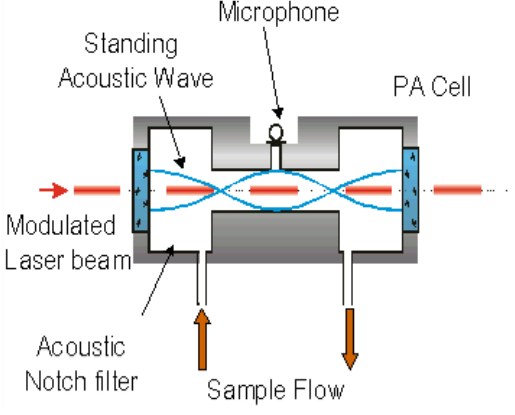
Figure 4. The principle of the photoacoustic measurement [12]. The diagram of the design of a resonant cell is shown in Figure 5.